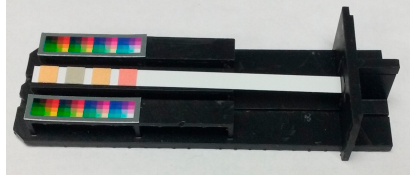
Figure 9. The bottom_base and the bottom_stripbed used in the measurement step.